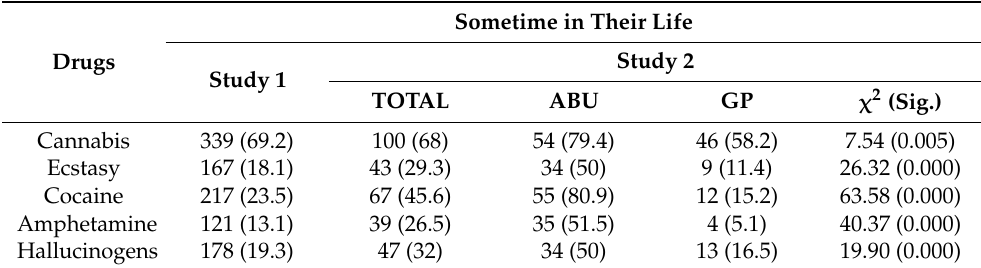
Table 2. Taken drugs sometime in their life for the three groups of this study. Drugs Study 1